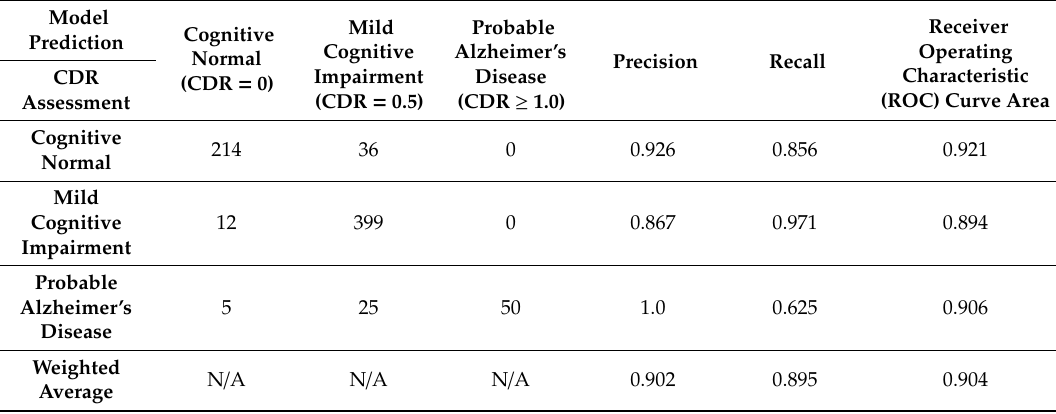
Figure 3. Percent accuracy for the support vector machines. Accuracies for predictions using both the standardized and normalized datasets are plotted. The α values are the criteria for feature selection for each model and are shown on the X -axis. Table 2. Confusion matrix of the best cross validation using standardization with a α of 0.1. The model prediction and the CDR assessment for all three cognitive groups is shown. Additionally, precision, accuracy, and ROC curve area, including the weighted average for the model, are